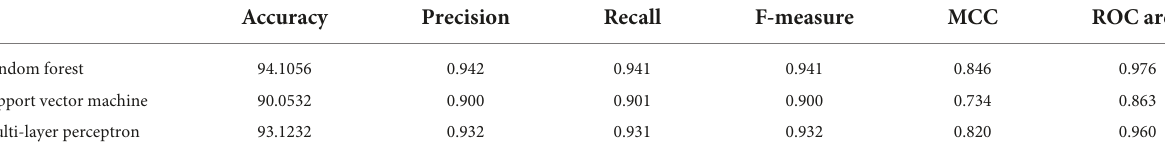
TABLE 1 Evaluation of machine learning models (RF, SVM, and MLP).